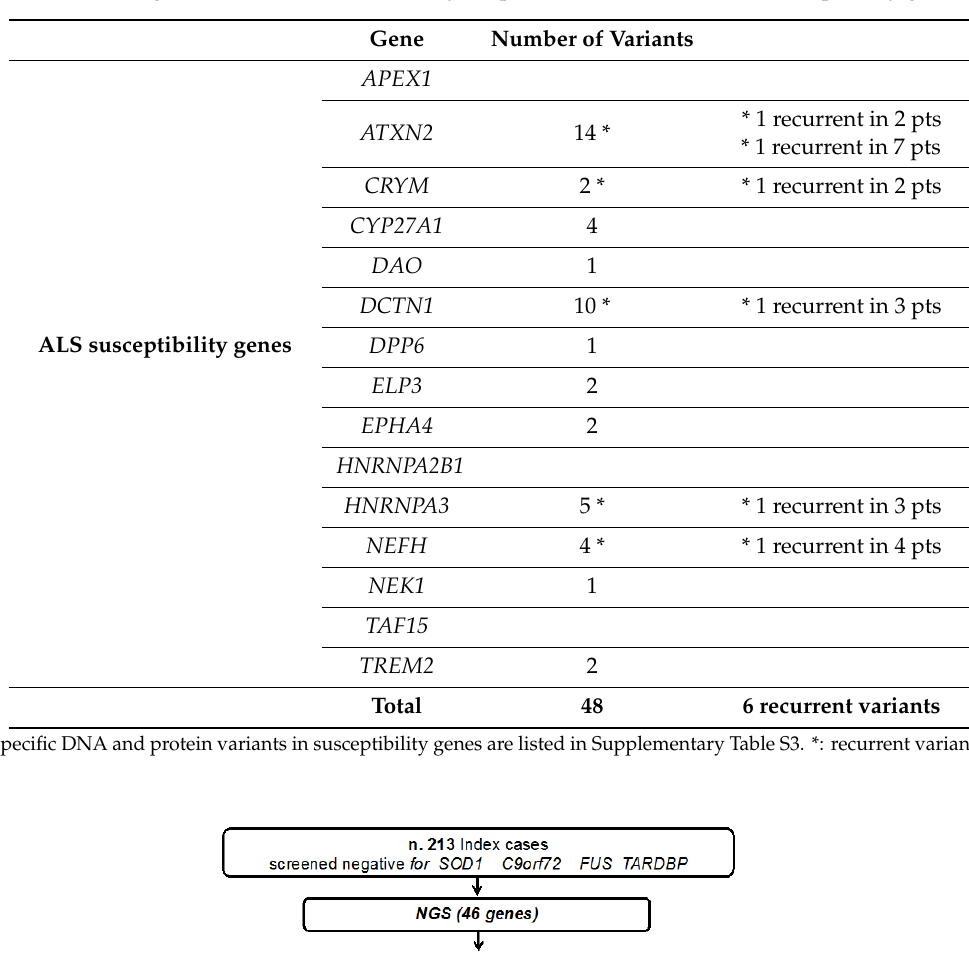
Table 3. Total gene variants identified in amyotrophic lateral sclerosis (ALS) susceptibility genes.